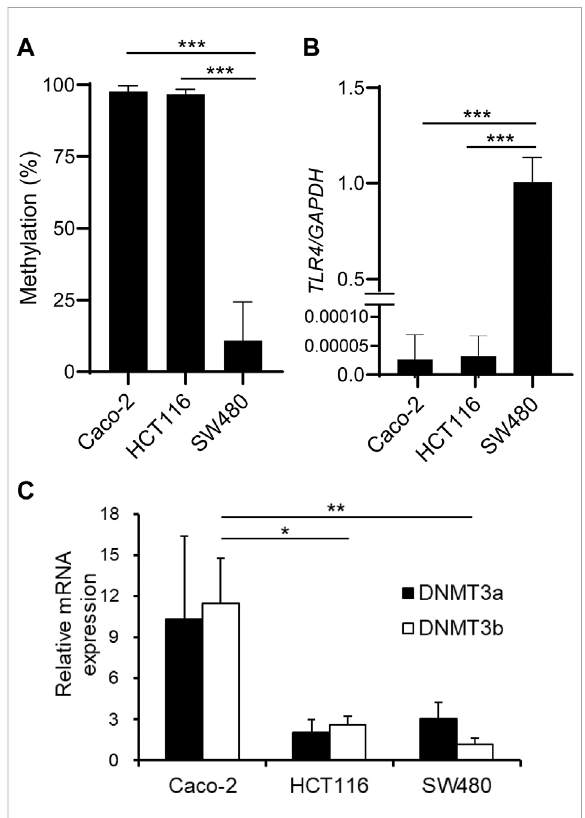
FIGURE 1 DNA methylation of the TLR4 gene does not correlate with DNMT expression levels in IEC lines. (A) DNA methylation status of the CpG motif at nt +115 of the TLR4 gene in human IEC lines Caco-2,HCT116,andSW480wasdeterminedbymethylation PCR.Resultsareexpressedasmethylationpercentageofthismotif and shown as mean ± SD of three independent experiments. *** Signi fi cantly different( p < 0.0001). (B) mRNA expression ofTLR4 in Caco-2, HCT116, and SW480 cells was analyzed by qRT-PCR. Relative expression levels are shown as mean ± SD of three independent experiments. *** Signi fi cantly different ( p < 0.0001). (C) mRNA expression of DNMT3a ( fi lled bars) and DNMT3b (open bars) in Caco-2, HCT116, and SW480 cells was analyzed by qRT- PCR. Results are shown as mean ± SD of three independent experiments. *, ** Signi fi cantly different (* p < 0.05, ** p <